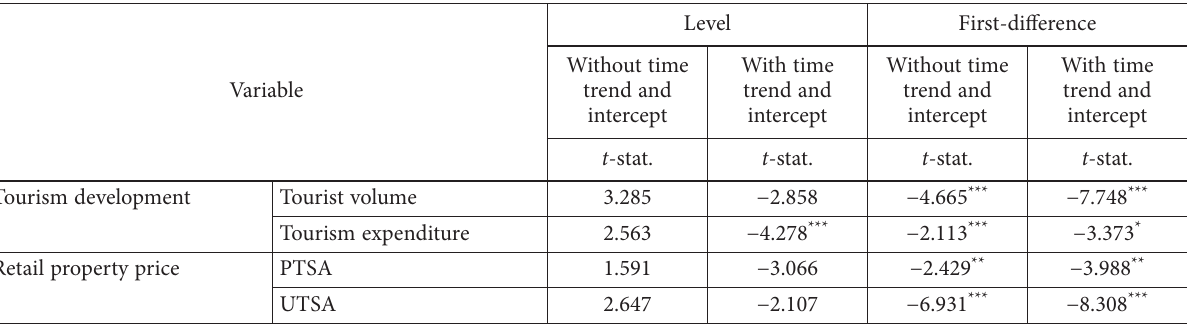
Table 2. Results of augmented Dickey-Fuller tests (unit root tests)